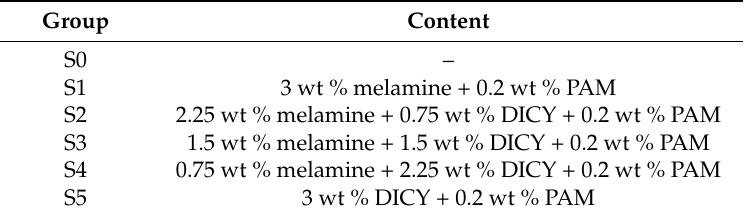
Table 1. The sample content. DICY: dicyandiamide, PAM: polyacrylamide.